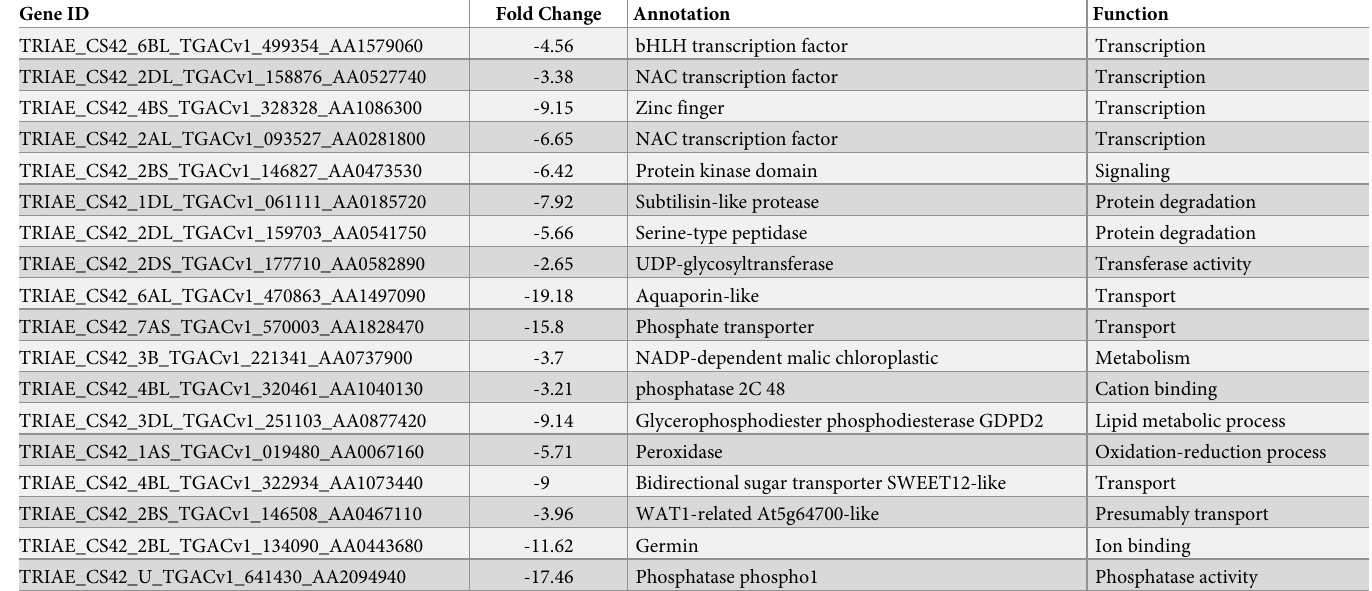
Table 5. List of specific genes which are significantly down-regulated in MD vs.